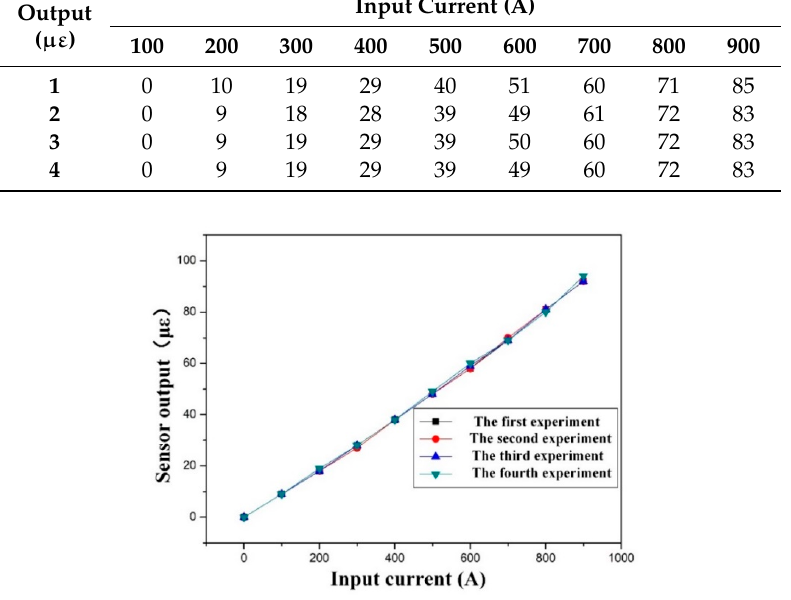
Figure 11. Repeatability test of